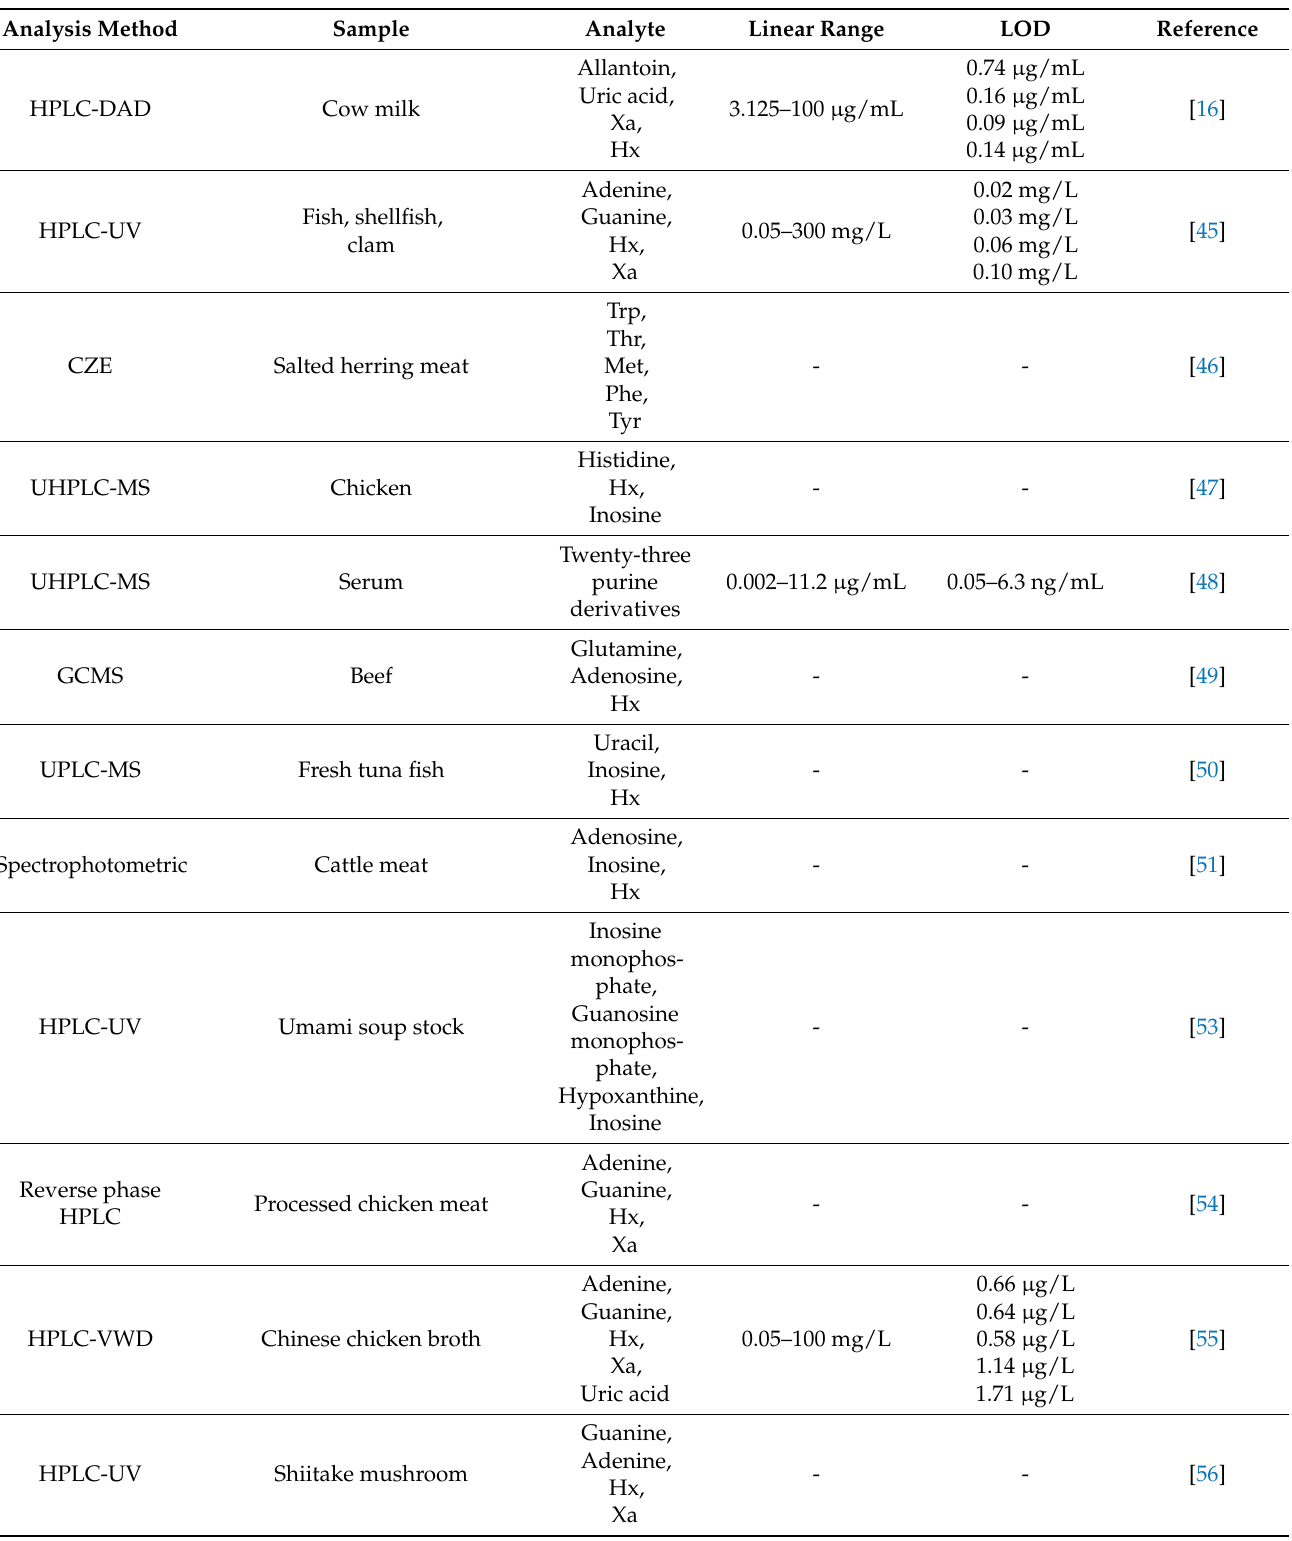
Table 1. Conventional methods for detecting purine and their analytical performance in food